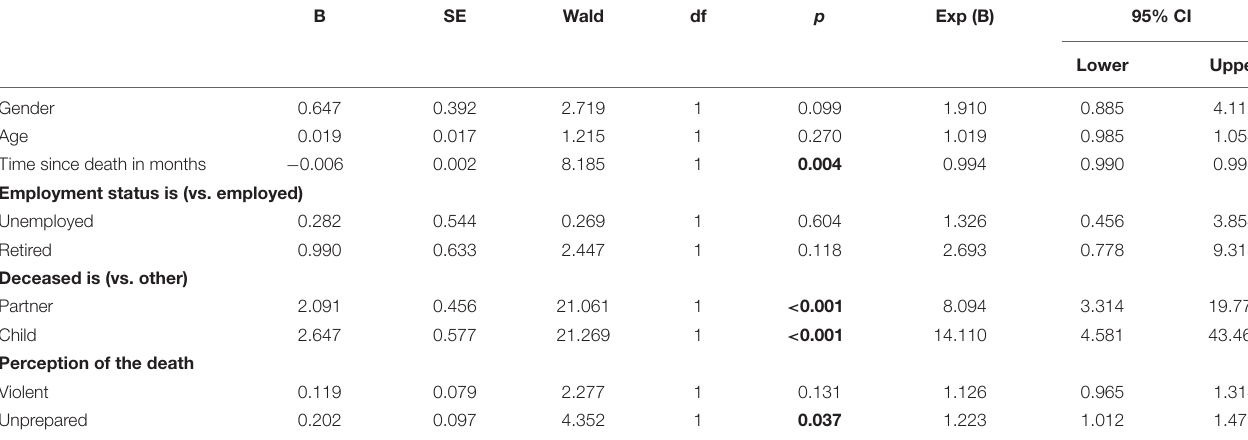
TABLE 3 | Binary logistic regression analysis of predictive variables for